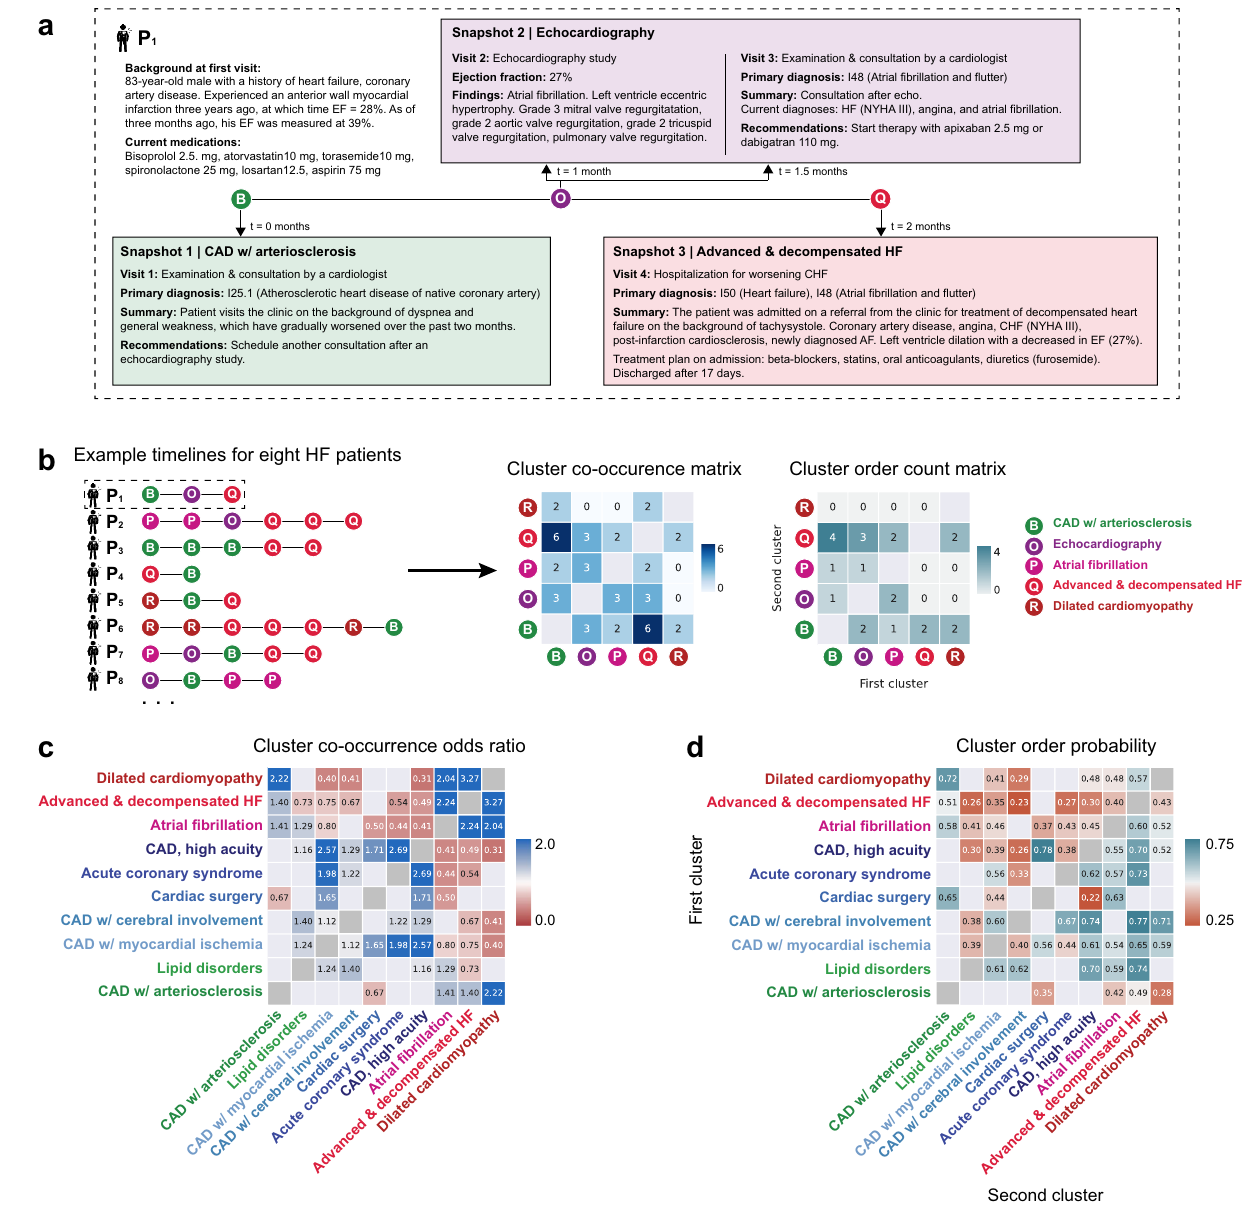
Figure 5. ( a ) Example timeline of a patient in the heart failure cohort. Visits have been aggregated into time bins and a clinical summary of the visits is provided. The disease state (cluster assignment) of each snapshot is shown. ( b ) Schematic illustrating the construction of a cluster co-occurrence matrix and cluster order count matrix using eight patient timelines from the HF cohort. The first timeline (P1) is expanded in ( a ). ( c ) Odds ratio of clusters co-occurring within HF patients for a selected subset of clusters, computed over all patients. Values greater than 1 (blue) indicate a positive association, while values less than 1 (red) indicate a negative association. Odds ratios falling outside of a 95% confidence interval are masked. ( d ) For selected cluster pairs, probability of the first cluster (y-axis) coming before the second cluster (x-axis) in patients in which both clusters co-occur across the entire HF